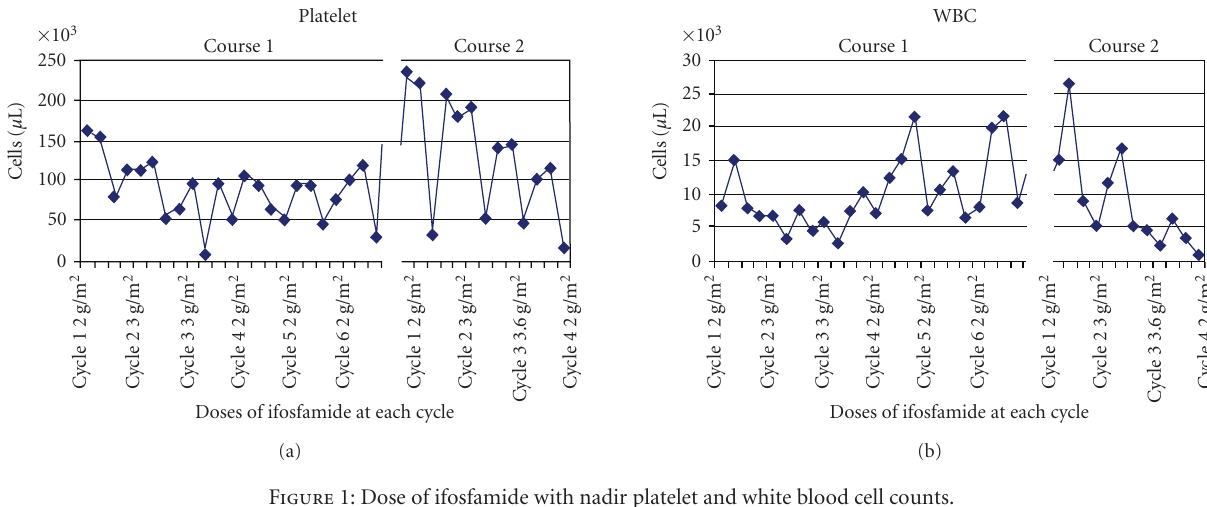
Figure 1: Dose of ifosfamide with nadir platelet and white blood cell counts. Table 2: Proposed plan for nonoliguric patients with ESRD on dialysis receiving ifosfamide. Day 1 Admit patient in the afternoon Forced diuresis: Furosemide 200 mg IVP over 1hour Match urine output with D5 + 0.45%NS (if patient oliguric/anuric, furosemide, Mesna, and IV fluids are not needed) Ifosfamide 1-2g/m 2 + Mesna, starting ifosfamide at 4–6 PM Day 2 HD in the AM (10–12 hrs after chemotherapy) Repeat furosemide and IV fluids as above Ifosfamide + Mesna, starting ifosfamide at